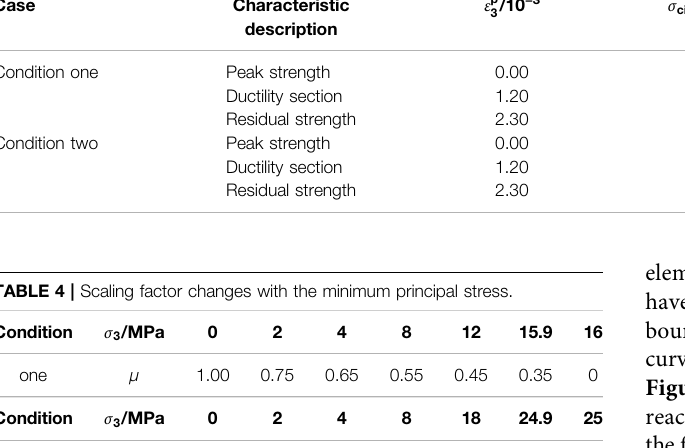
TABLE 3 | Strength parameters of rock mass change with the plastic strain. Case